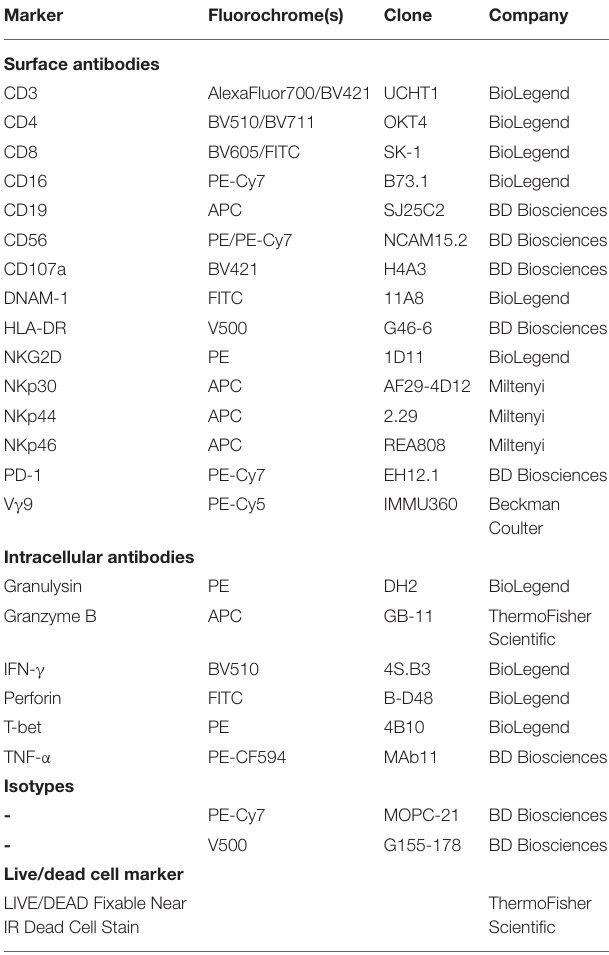
TABLE 1 | Antibodies used in this